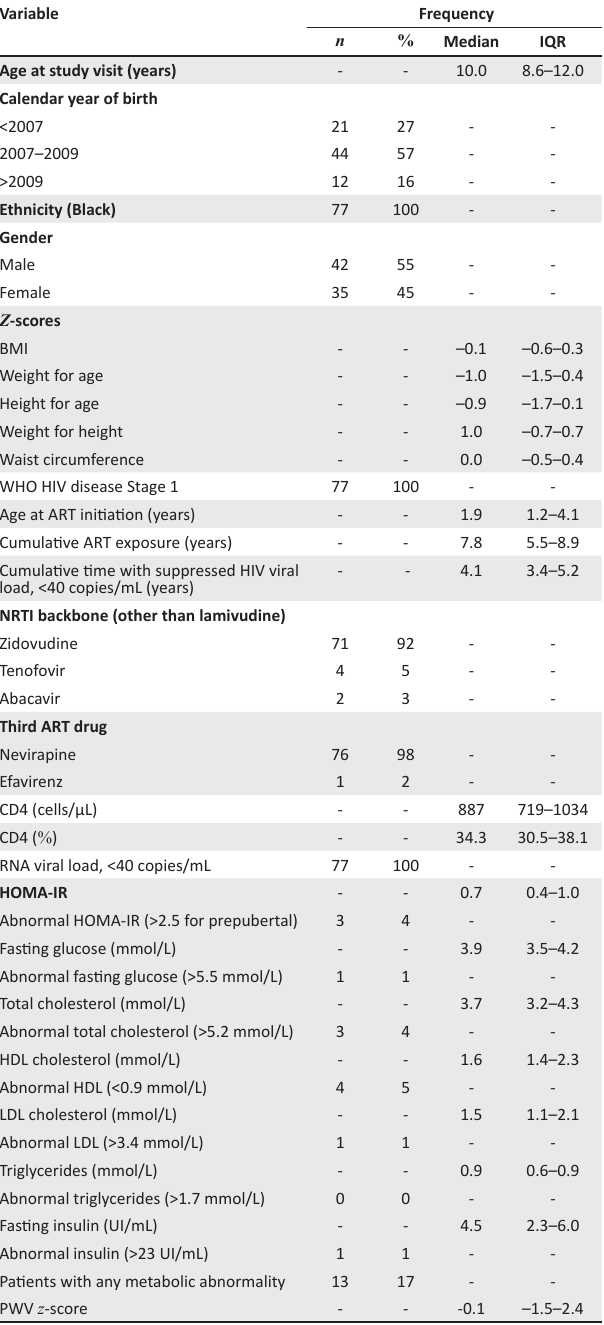
TABLE 1: Characteristics of the participants ( n = 77). TABLE 2: Multivariable linear regression model with pulse wave velocity z -score as